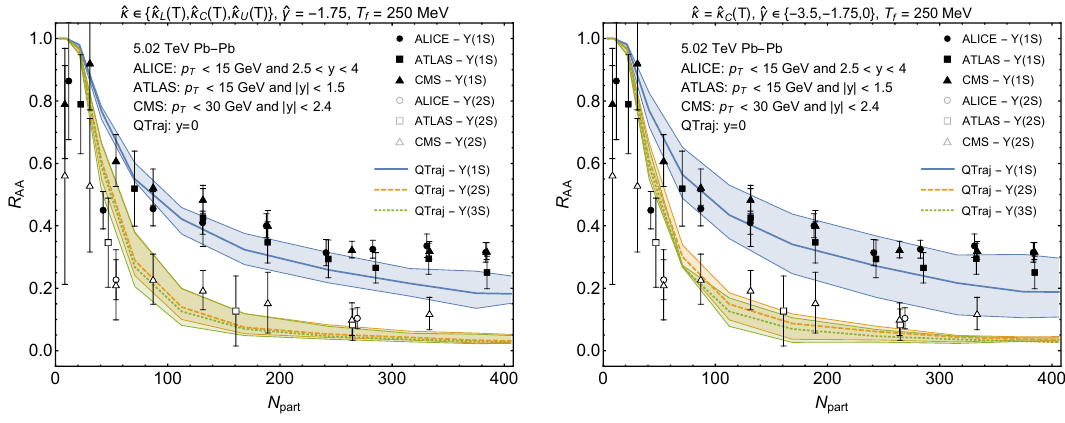
Figure 10 . R AA of singlet S -wave states versus N part taking into account excited state feed down. The bands shown in the left and right panels correspond to the variations detailed in the caption of figure 6. The data points are from the ALICE [100], ATLAS [101], and CMS [96] collaborations. The experimental error bars were obtained by adding statistical and systematic uncertainties in